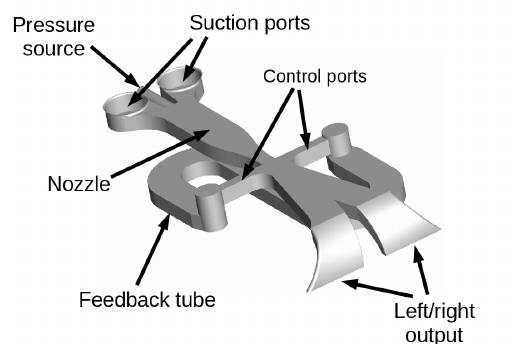
Figure 2. The geometry of the SaOB actuator; the shade color represents the adiabatic wall boundary